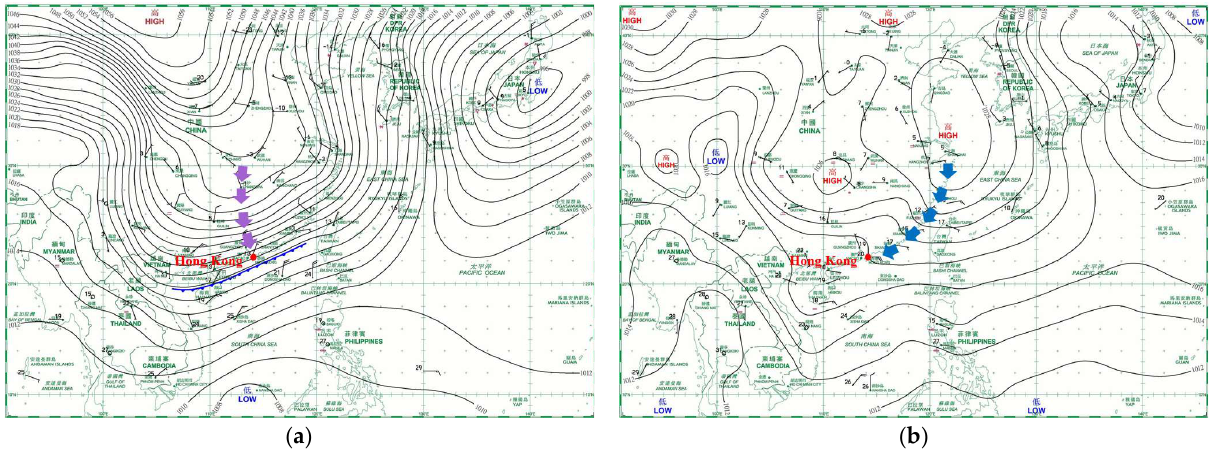
Figure 1. Typical surface pressure patterns of monsoon surges: ( a ) a northerly surge (at 00 UTC on 30 November 2020); and ( b ) an easterly surge (at 12 UTC on 2 February 2021). The location of Hong Kong is marked in red, and the direction of flow towards Hong Kong is marked by arrows.